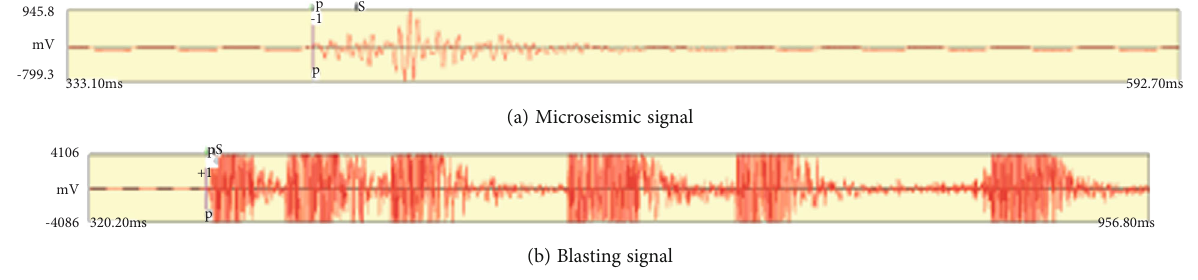
Figure 8: Typical microseismic and blasting event signal waveforms.